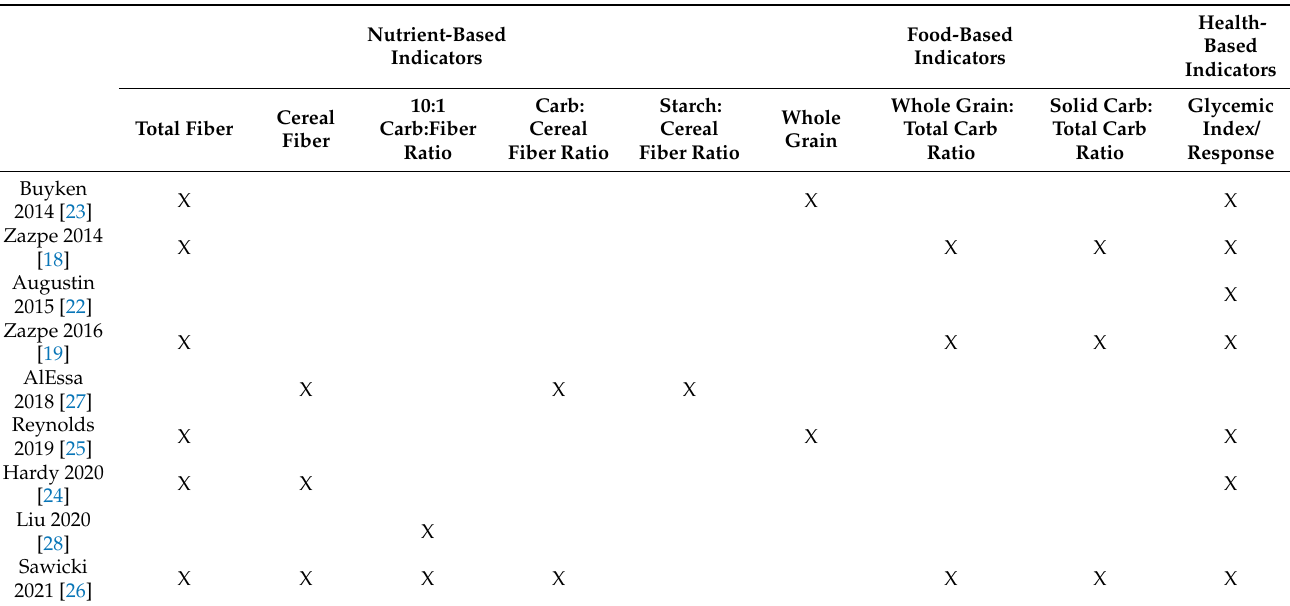
Table 3. Selected Examples of Carbohydrate Quality Indicators and their